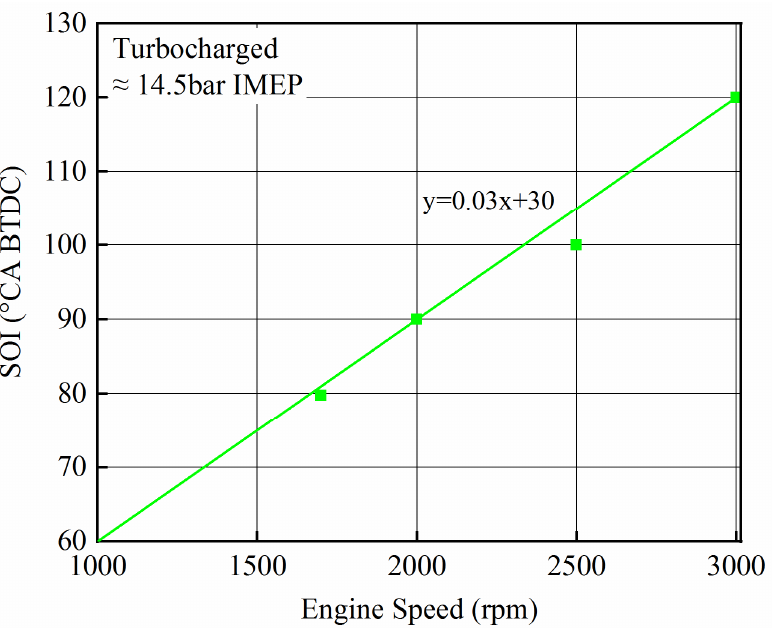
Figure 1. Optimal injection timing at different engine speeds [18].